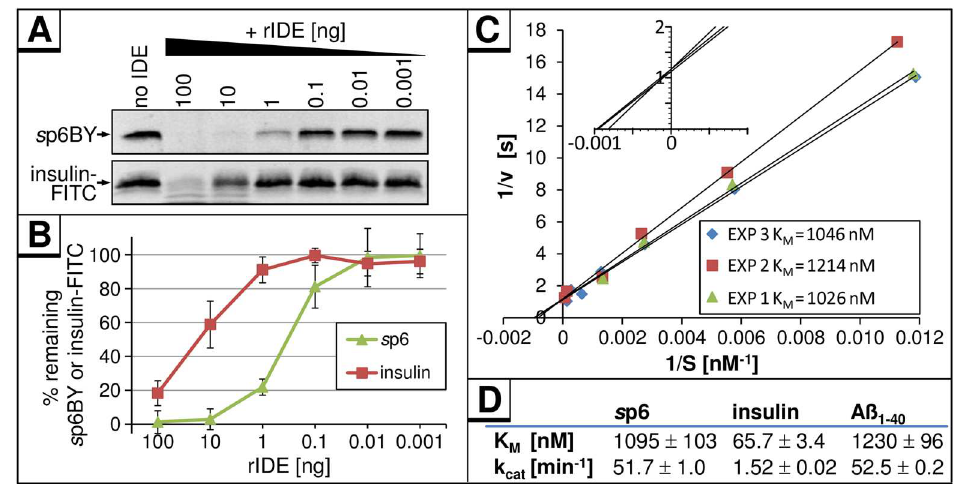
Fig 7. s p6 is an up to 100-fold better IDE-substrate than insulin. (A) 10 ng of s p6BY or insulin-FITCwere incubatedwith indicatedamounts of rIDE for 30 min at 37˚C. Remainingamounts of s p6BY and insulin-FITC were detected by measurement of fluorescence excitation. (B) Results of four independently performed experiments. Values represent the arithmetic mean ± SD. (C) Increasingconcentrations of s p6BY were incubatedwith rIDE for 10 min at 37˚C. The velocitieswere calculatedfrom the degradationof s p6BY and normalized for the amount of rIDE. Data points represent values from three independentexperiments in a double-reciprocalLineweaver-Burk plot. The inset shows a magnification of the intersections of the regression lines with the axes. (D) Comparisonof K M and v max values for s p6BYand IDE as determinedin (C) to those of IDE and insulinor A β as reported[47].